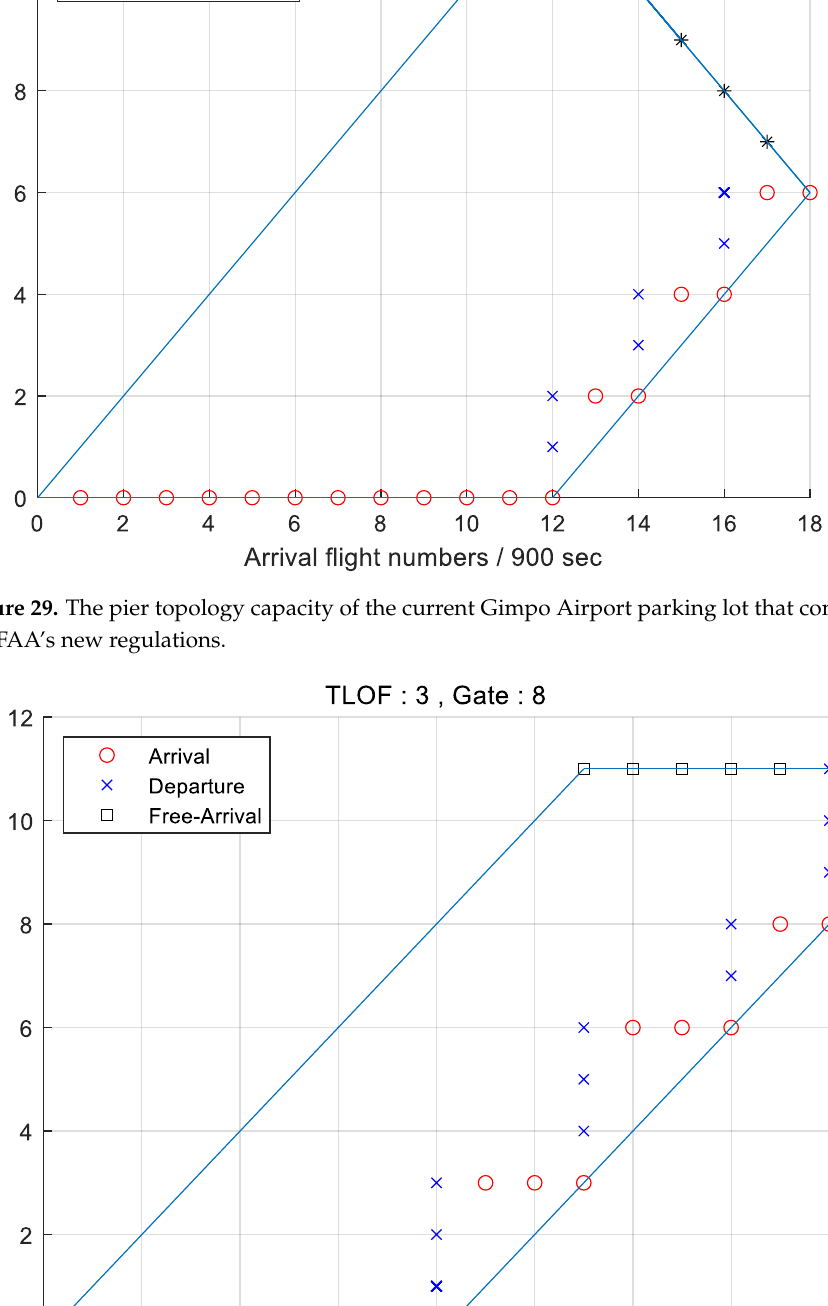
Figure 30. Capacity of a linear topology for the current Gimpo Airport parking lot that complies with the EASA’s new regulations.